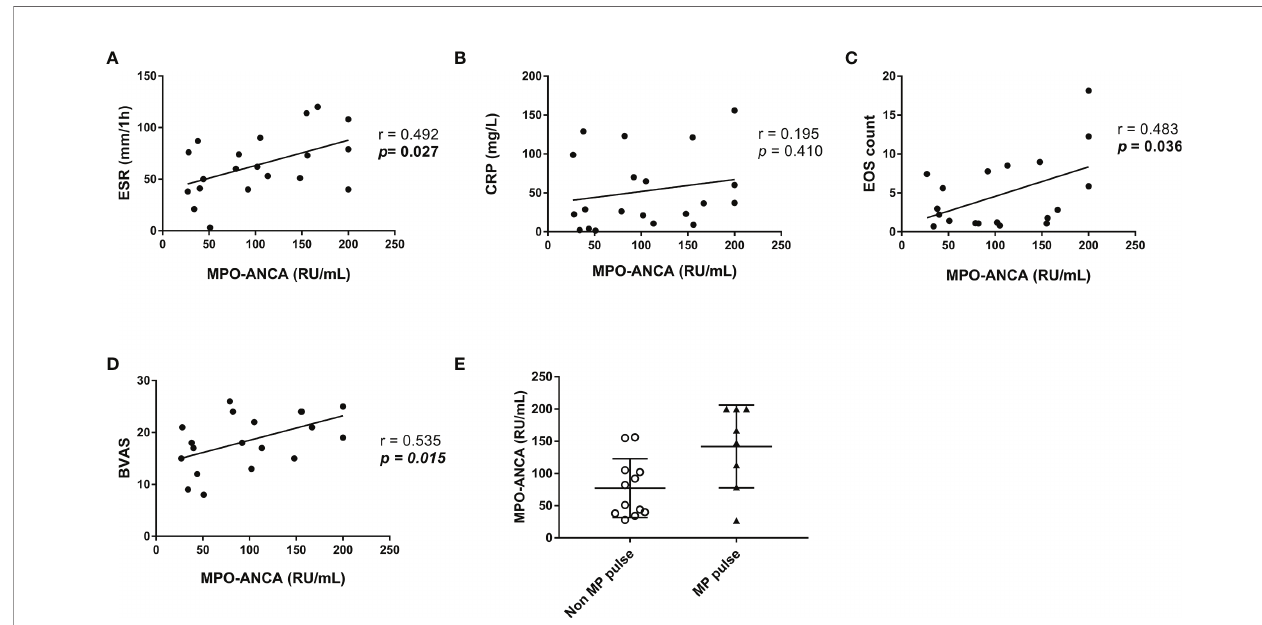
FIGURE 1 | Correlation of MPO-ANCA titers at baseline with other parameters in the patients with MPO-ANCA-positive EGPA. (A – D) Correlation of MPO-ANCA titers with ESR, CRP, EOS count, and BVAS. Pearson correlation was used for the analysis. (E) Comparison of MPO-ANCA titers between patients with and without MP pulse. ANCA, antineutrophil cytoplasmic antibody; BVAS, Birmingham Vasculitis Activity Score; CRP, C-reactive protein; EGPA, eosinophilic granulomatosis with polyangiitis; EOS, eosinophil; ESR, erythrocyte sedimentation rate; MP, methylprednisolone; MPO,